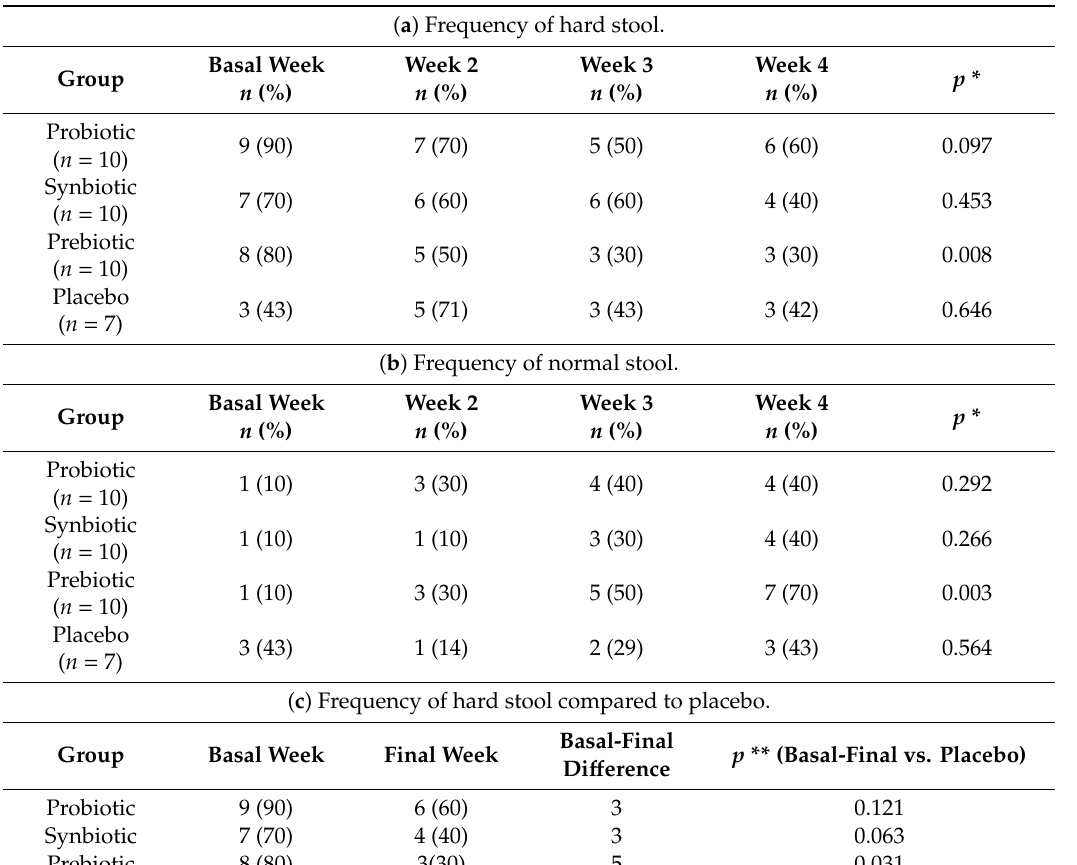
Table 3. Frequency of hard and normal stool by